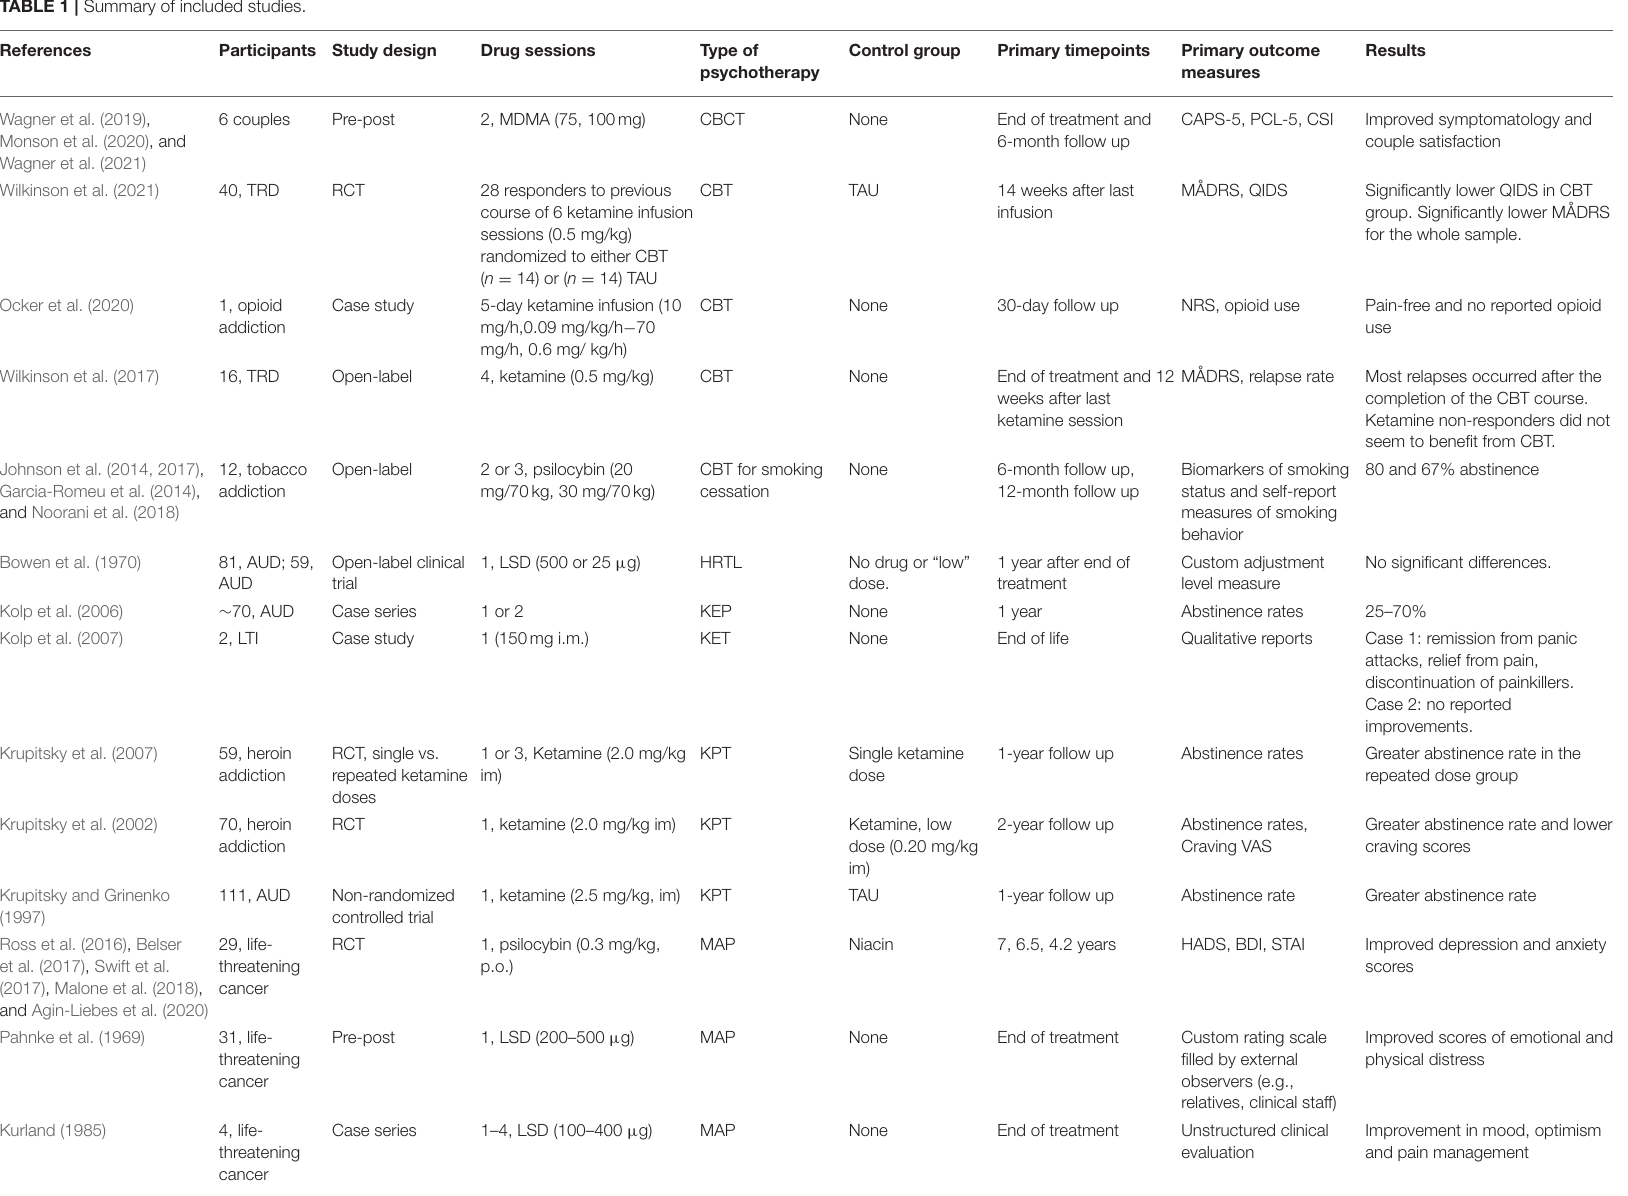
TABLE 1 | Summary of included